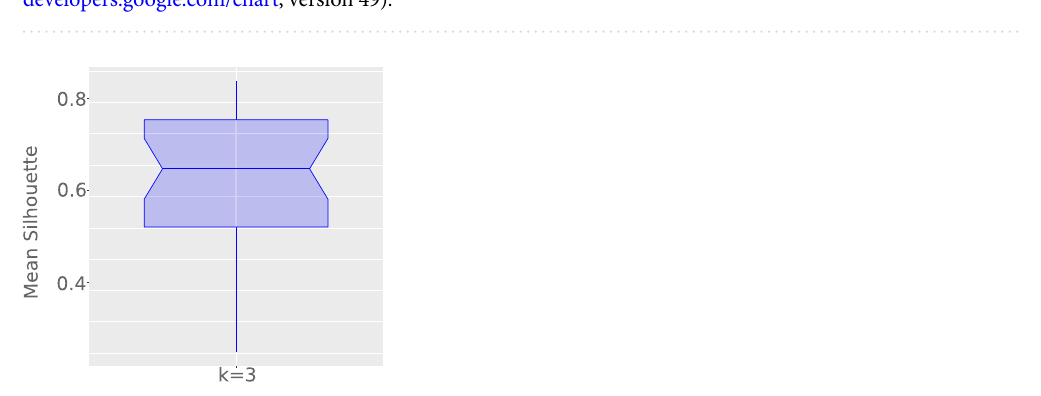
Figure 4. Confirmed cases per million inhabitants: country partitions along weeks 16–32. Top images identify country groups and bottom curves correspond to the infection incidence levels: green, orange and purple correspondingly map the low, medium and high-incidence groups. Curve legends indicate the group descriptor. Top-most maps were generated by using Tableau Desktop-Professional Edition (https:// www. table au. com/, version 20181.20.0213.2110-64 bit), and bottom-most charts were generated by using Google Charts (https:// devel opers. google. com/ chart, version 49).